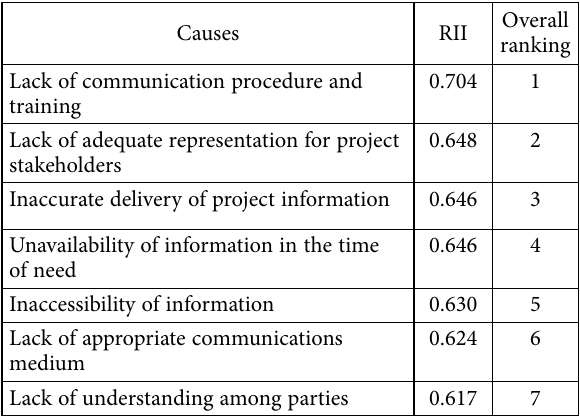
Table 8. RII and ranking of the causes of poor communication Causes RII